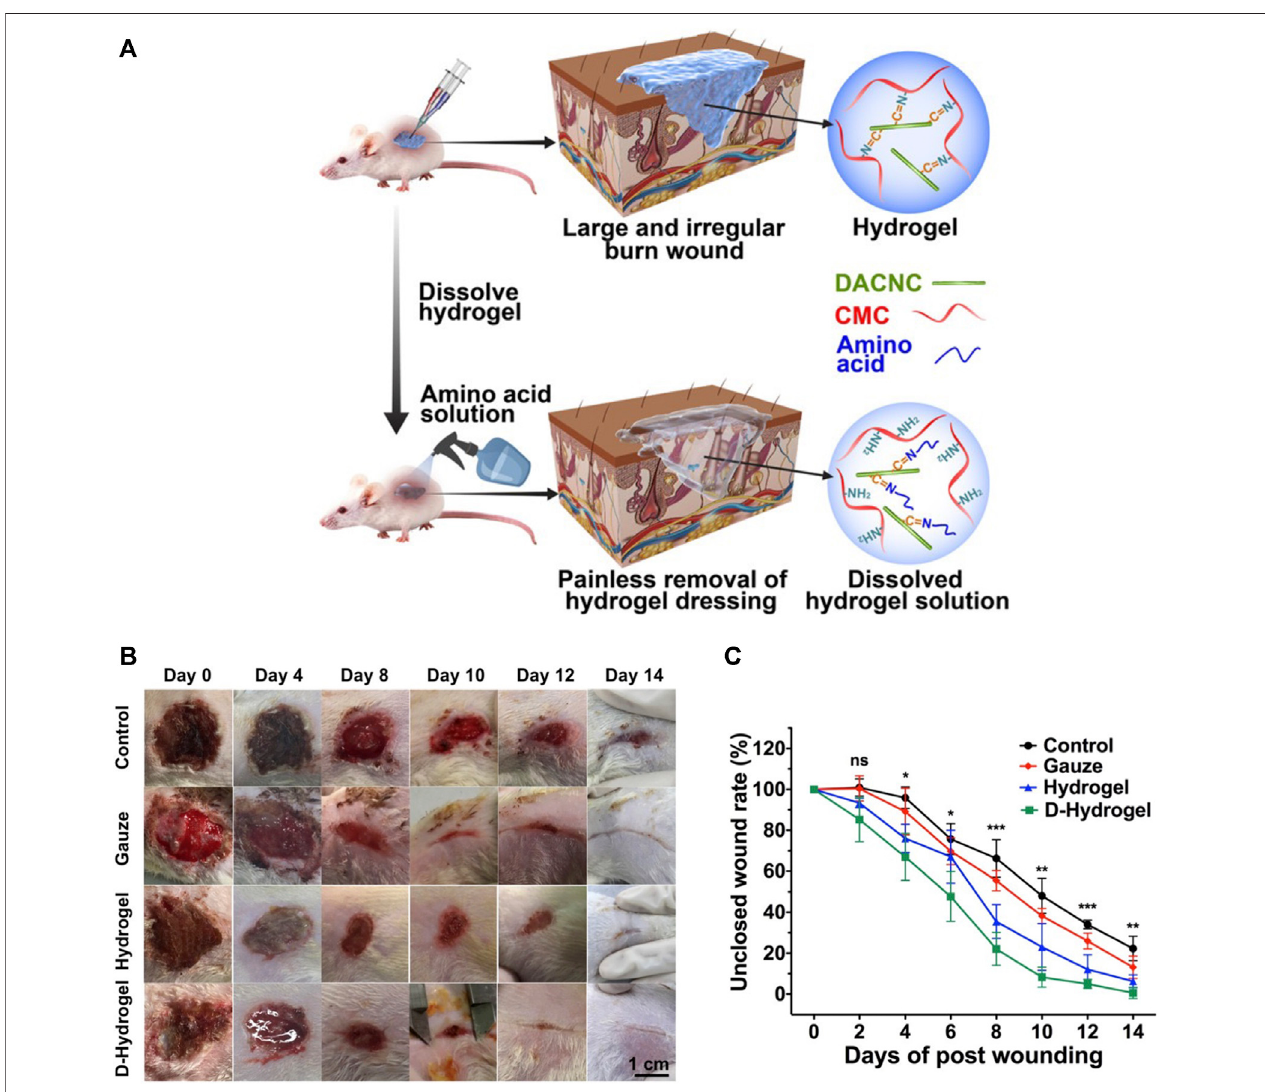
FIGURE4| “ Ondemand ” dissolvablehydrogelsforthehealingofdeeppartial-thickness burns. (A) Howon-demanddissolvableself-healinghydrogelsareusedto treat wounds (schematic). (B) Representative images of wound sites in each treatment group over time. (C) Unclosed wound area rate of initial wound as a function of time. ns p > 0.05, * p ≤ 0.05, ** p ≥ 0.01, *** p ≤ 0.001. Reproduced with permission from (Huang et al.,